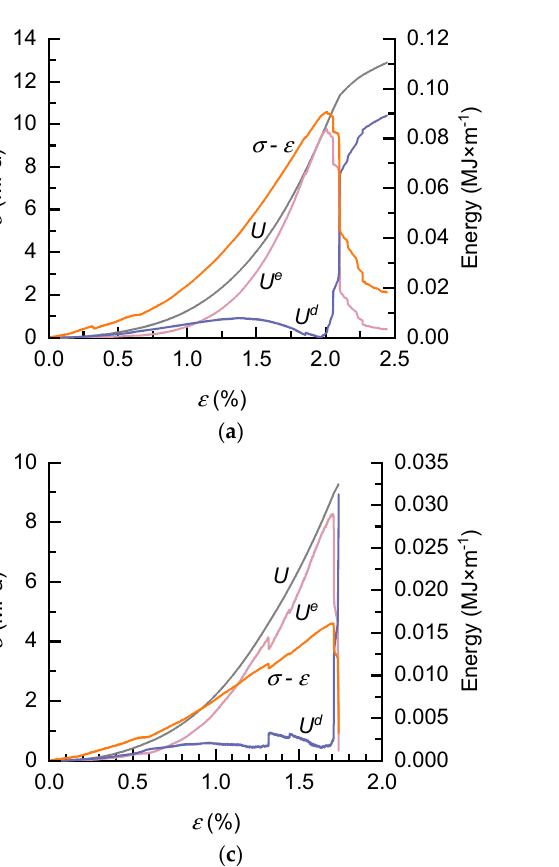
Figure 15. Coal sample different dry–wet circulation times, stresses, and energy diagrams. They should be listed as: ( a ) N = 1; ( b ) N = 2; ( c ) N = 3; ( d ) energy dissipation comparison.